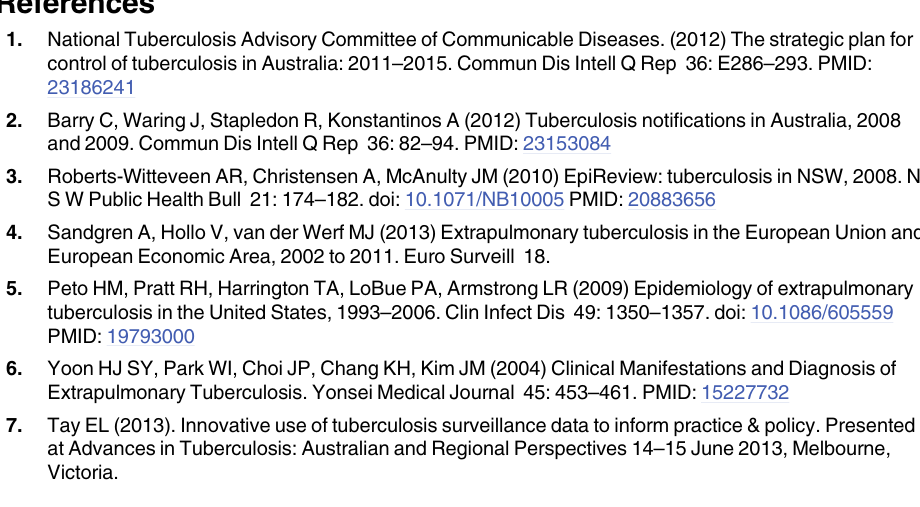
S1 Table. Quality domains examined in characterisation of management